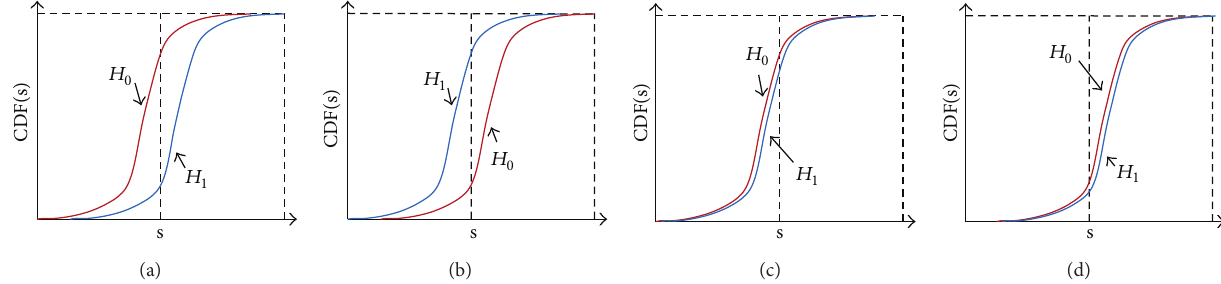
Figure 1: The CDF of received signal energy at CU under absence and presence hypothesis of PU signal for (a) normal CU, (b) opposite malicious CU, (c) always Yes malicious CU, and (d) always No malicious